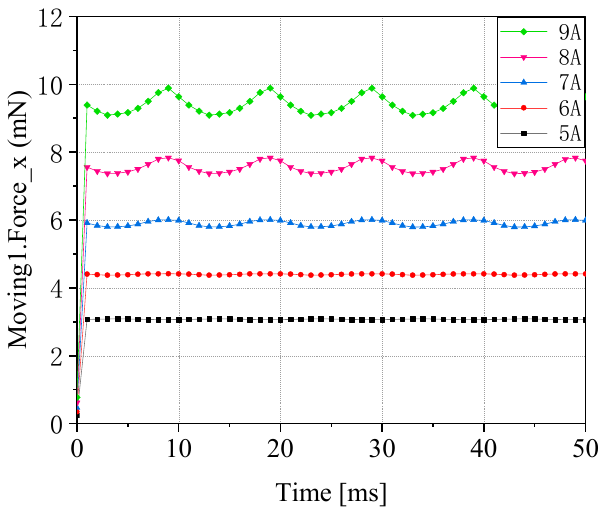
Figure 11. Electromagnetic force generated at di ff erent currents.